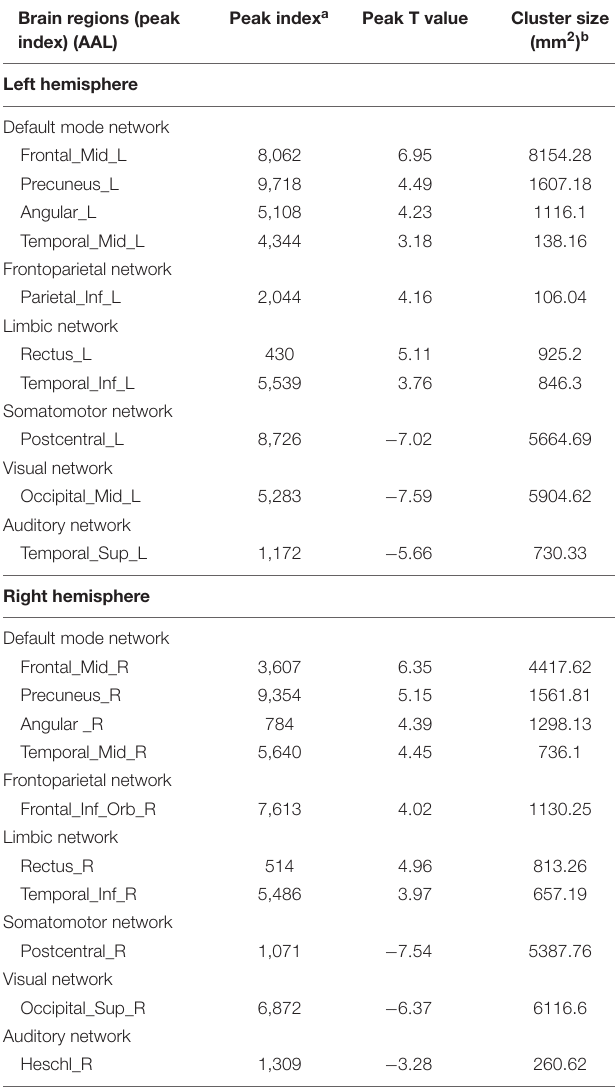
TABLE 2 | Group differences in the surface-based